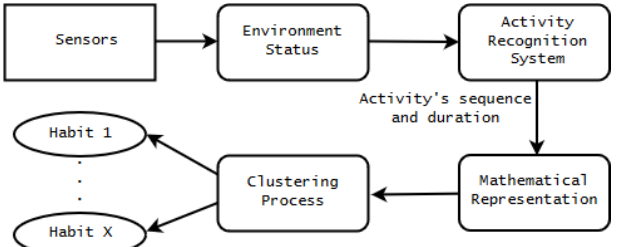
Figure 1. Overall architecture of the user habits assessment system. The conditional matrix and activity frame [19] were applied to extract the sequence with activity ID and duration [minutes] in this activity recognition system.